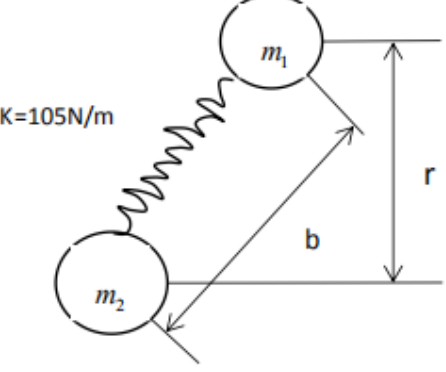
Figure 3. The inverted pendulum model. Figure 4 and Figure 5 show the fault detection caused by interconnection within sub- system 1 and subsystem 2 by the decentralized fault detection scheme, and compare the d . It is assumed that subsystem 1 and subsystem 2 different detection thresholds i cause interconnection failure at t = 2 s and t = 3 s, respectively, due to the influence of modeling uncertainties.